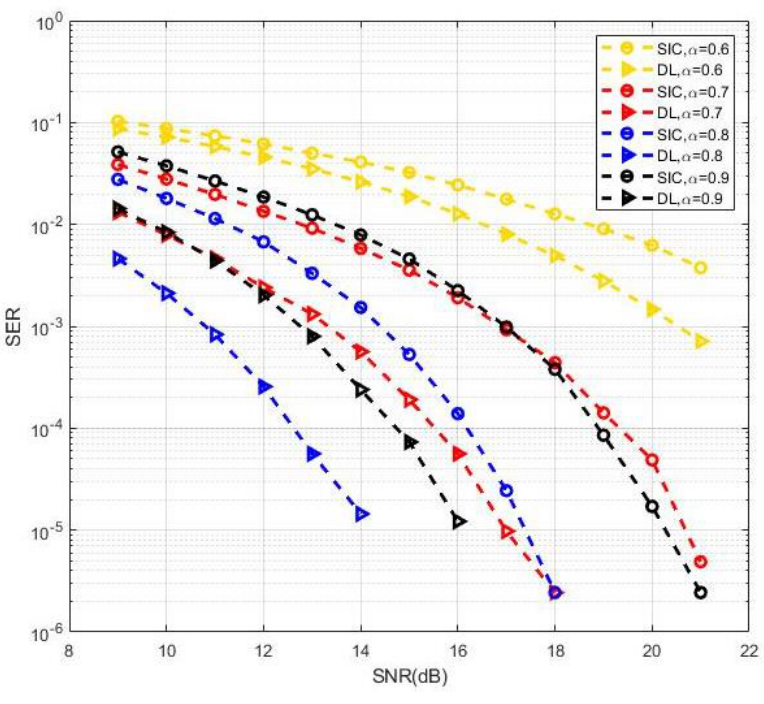
Figure 13. SER performance with different power allocation